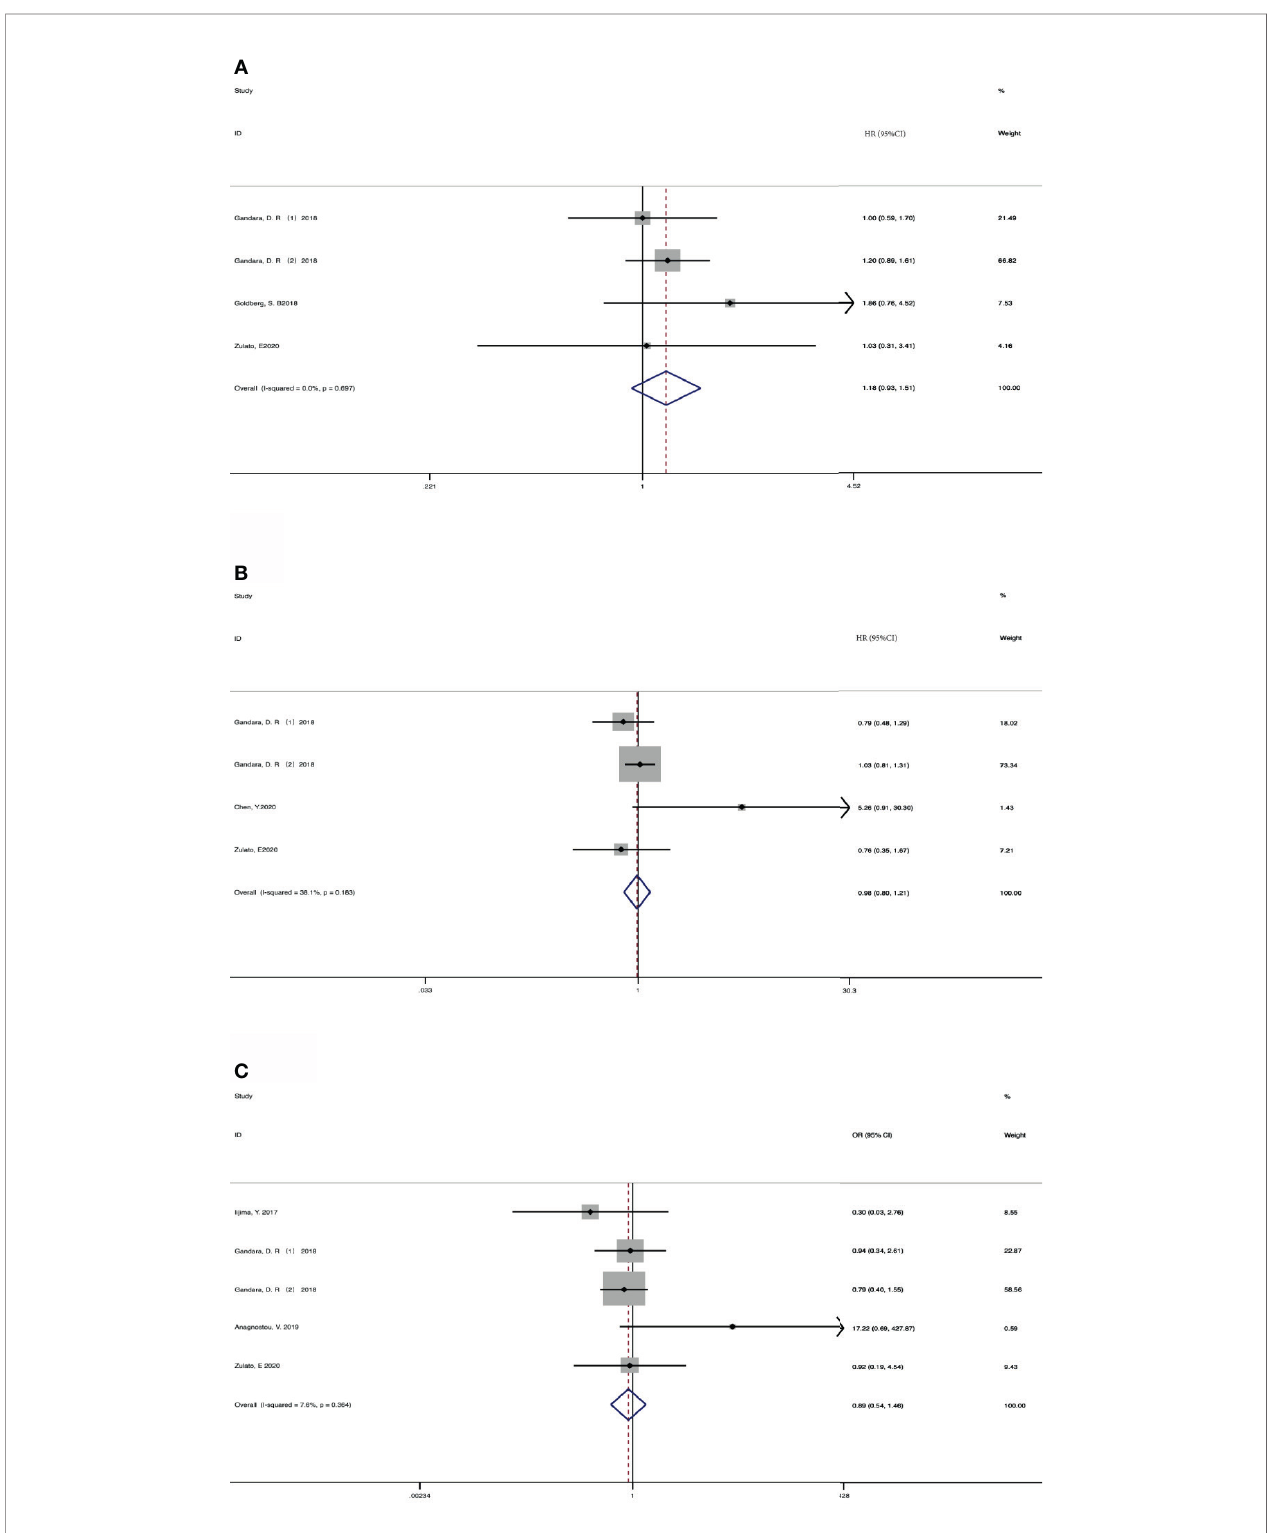
FIGURE 2 | Meta-analysis of the associations between baseline ctDNA and (A) overall survival, (B) progression-free survival, (C) objective response rate. HR, hazard ratio; OR, odds